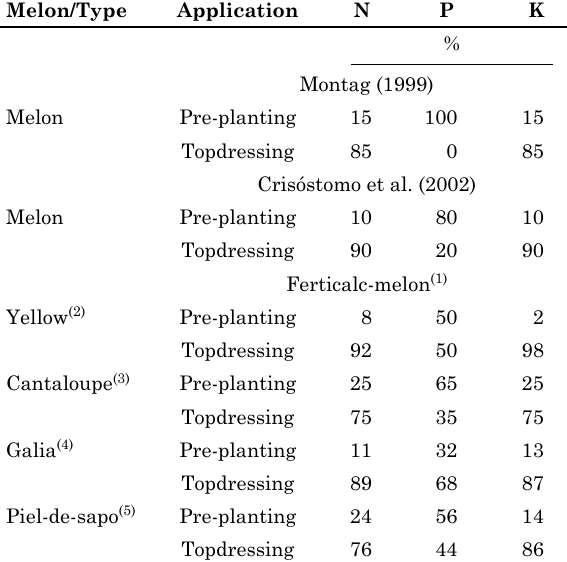
(1) Distribution suggested by the system based on fertilizers used in field experiments with total fruit yield ≥30 t ha -1 ; (2) Data base for the Yellow type used to suggest the distribution in Ferticalc- melon: Araújo Junior (2008), Oliveira (2010), Fernandes (2010), Pereira (2010), and Tomaz (2008); (3) Data base for the Cantaloupe type used to suggest the distribution in Ferticalc-melon: Araújo Junior (2008), Dantas (2007), Pereira (2010), Gerhardt (2007), Prata (1999), Duarte (2002), and Damasceno (2011); (4) Data base for the Galia type used to suggest the distribution in Ferticalc- melon: Pereira (2010), Gerhardt (2007), and Santos Junior (2007); ( 5) Data base for the Piel-de-sapo type used to suggest the distribution in Ferticalc-melon: Pereira (2010), Rodrigues (2008), Dantas (2008), and Temóteo